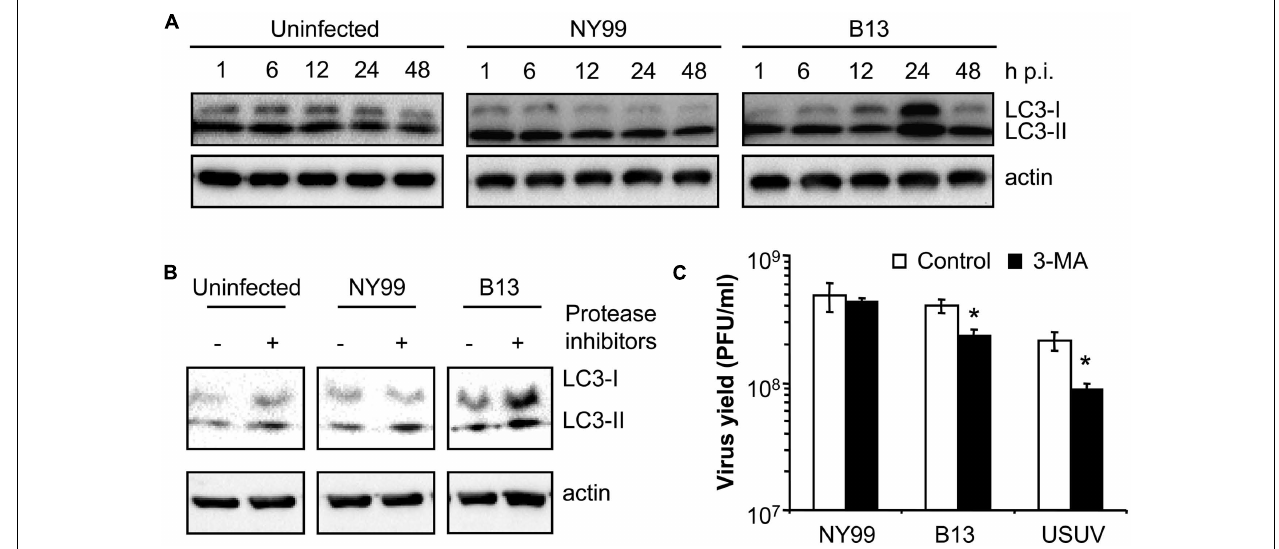
FIGURE 2 | Characterization of the differences between WNV NY99 and B13 variant. (A) Time course analysis of LC3 modification following infection by WNV NY99 or B13. Vero cells infected with WNV NY99 or B13 (MOI of 0.5 PFU/cell) were lysed at 1, 6, 12, 24, or 48 h p.i. and subjected to western blot analysis using an antibody against LC3 to detect non-lipidated LC3 (LC3-I) and LC3 conjugated to phosphatidylethanolamine (LC3-II). An anti- β -actin antibody was also used as control for protein loading. Mock-infected cells were analyzed in parallel to show the levels of LC3-II in uninfected cells. (B) Analysis of LC3 modification following infection by WNV NY99 or B13 including protease inhibitors (E-64d and pepstatin A). Vero cells were infected with WNV NY99 or B13 (MOI of